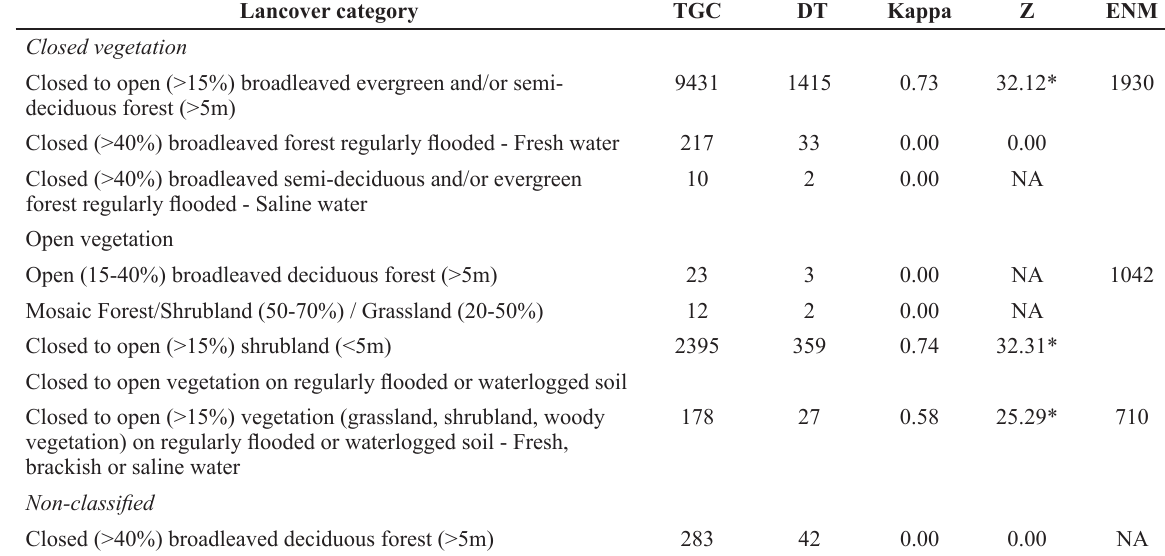
Data on number of locations used in the modelling approach and accuracy statistics for the decision tree classification. The native vegetation categories follow the GlobCover map (available at http://due.esrin.esa.int/page_globcover.php). Total number of grid cells for each native landcover category (TGC), the grid cell number used to aggregate climatically- similar cells through the decision tree analysis (DT), the accuracy statistics of the decision tree classification (Kappa and Z statistics), and to predict distribution of the landcover group through ecological niche modelling (enM) are